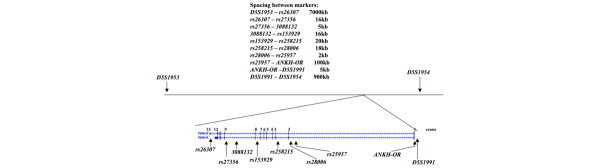
Locations and spacings of genetic markers used for genotyping. D5S1991 and ANKH-OR are located at the 5' flanking region of ANKH. All seven single nucleotide polymorphisms used are located in the introns of ANKH.